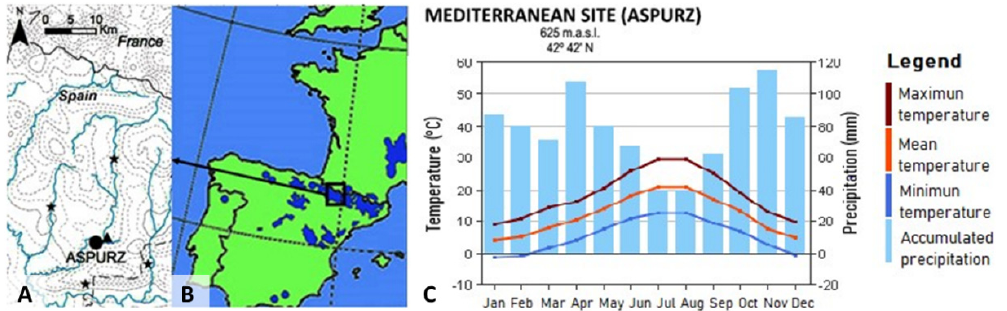
Figure 1. ( A ) Location of the experimental plots (circle) and the weather station (Navascués) providing historical climate (triangle), and the one used to fill weather records gaps (stars). ( B ) Location of the area in the Iberian Peninsula within the distribution of Scots pine in the region [32]. ( C ) Climatic diagrams for the study site for the period 1984–2019 [33].